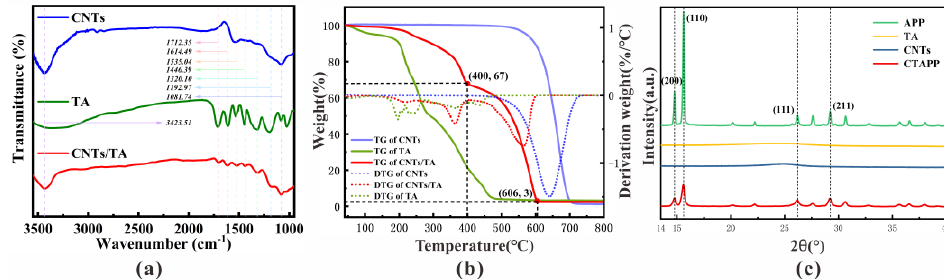
Figure 1. ( a ) The FT-IR patterns of CNTs, TA and CNTs/TA. ( b ) TG and DTG thermograms of APP and CTAPP in O 2 atmosphere ( V O APP, TA, CNTs and